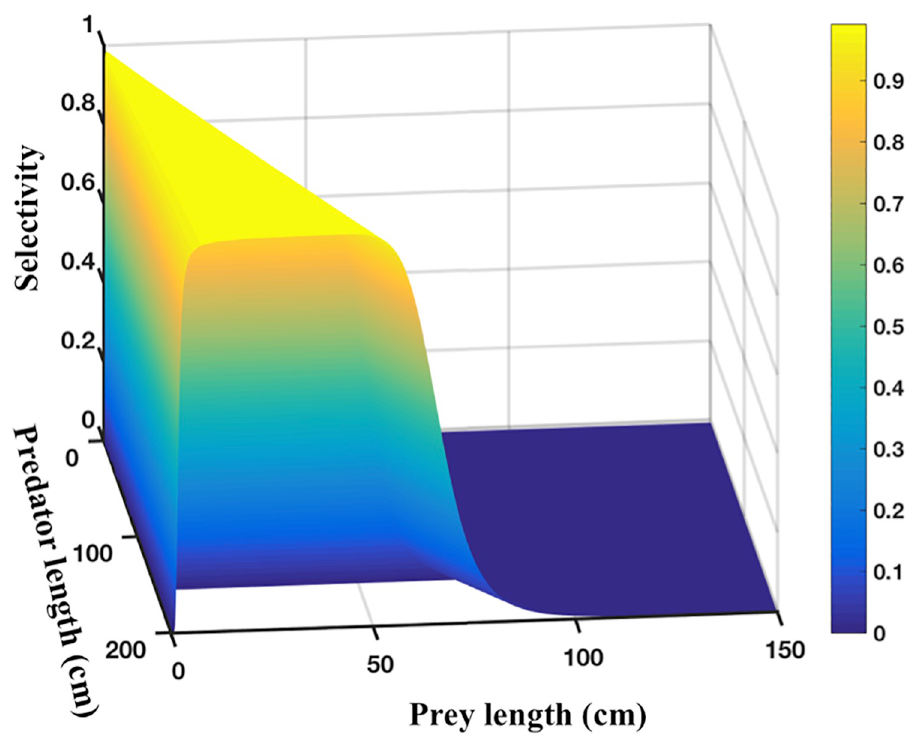
Fig 1. Probability of selectivity versus prey length and predator length, calculated from Eq